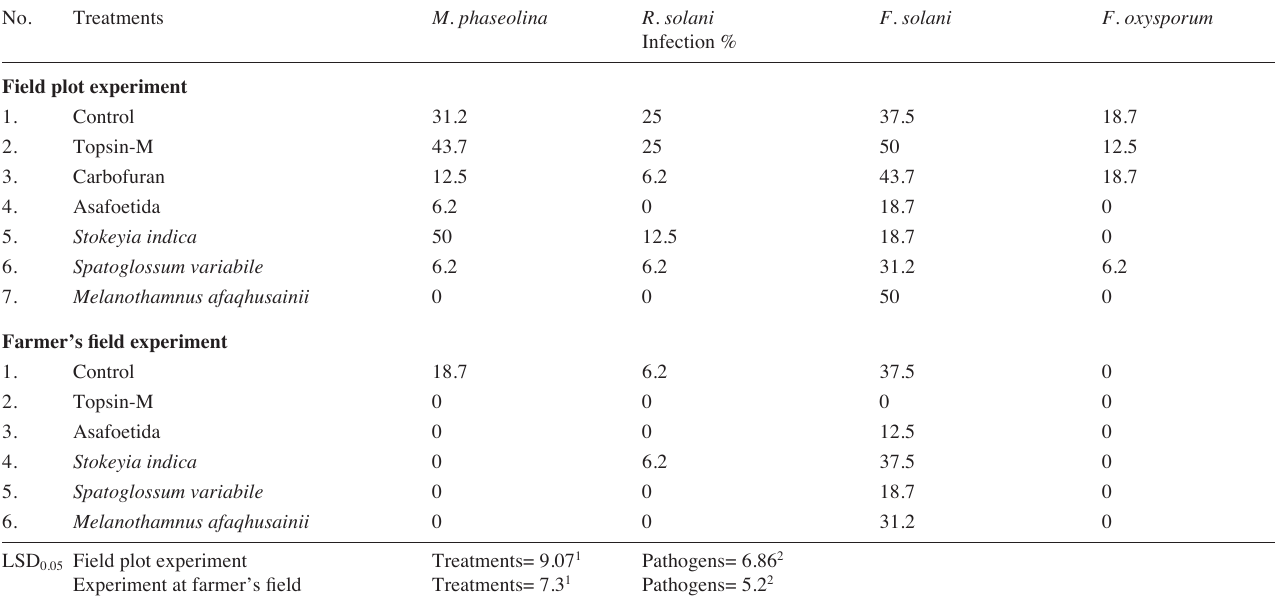
Tab. 3: Effect of asafoetida and seaweeds on the infection of root infecting fungi on watermelon in field plot experiment (after 45 days of nematode inocu- lation) and at farmer’s field (after 80 days of sowing). No.